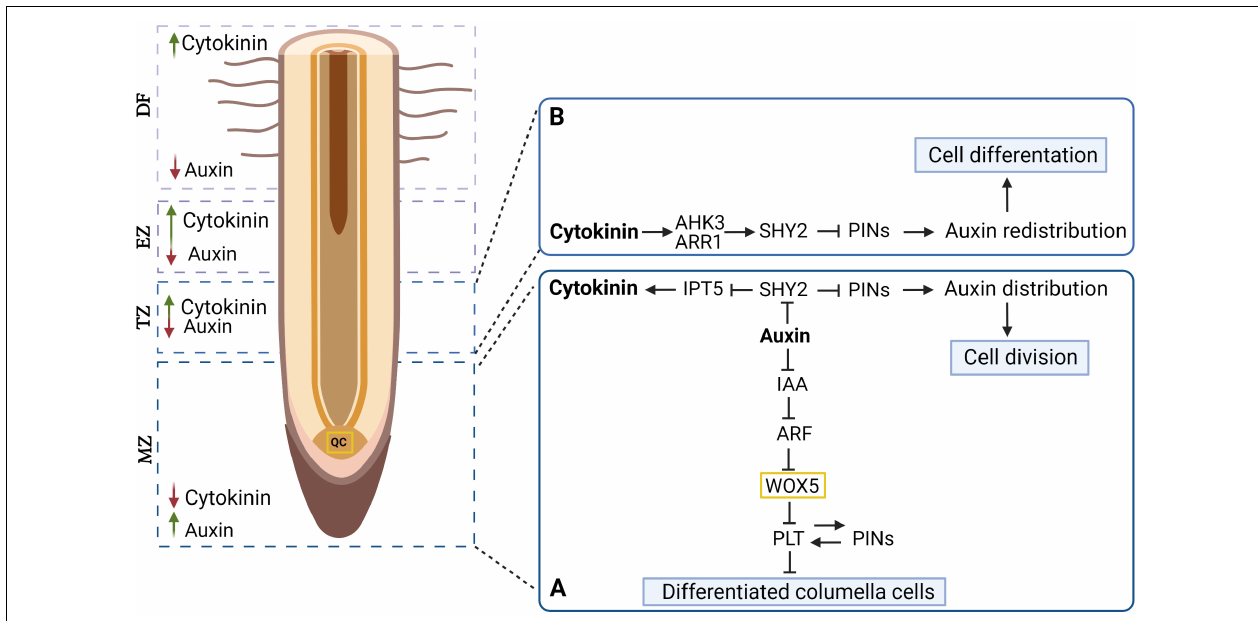
FIGURE 2 | Mechanism of auxin and cytokinin interaction in root meristem development. The distribution of auxin and cytokinin in different lots of the longitudinal section of the tree root is shown (green arrow – higher level, red arrow – lower level). (A) Auxin mediating WOX5 (expressed in the quiescent center cells (QC) and PLT (expressed in the stem cells surrounding the QC) expression plays a key role in the differentiation of columella cells. Also, in the apical root meristem, auxin by degrading SHY2 proteins promotes the expression of PINs, which control the auxin gradient and subsequently affect cell division. (B) In contrast to the auxin, cytokinin inhibits PIN expression by promoting SHY2 expression, leading to auxin redistribution and cell differentiation. PLT, PLETHORA; PINs, PINFORMED; WOX, WUSCHEL RELATED HOMEOBOX 5; ARF, AUXIN RESPONSE FACTOR; IAA, INDOLE-3-ACETIC ACID; SHY2, SHORT HYPOCOTYL 2; IPT5, ISOPENTENYL-TRANSFERASE 5; AHK3, ARABIDOPSIS HIS KINASE 3; ARR1, ARR TRANSCRIPTION FACTORS; MZ, meristematic zone; TZ, transition zone; EZ, elongation zone; DF, differentiation zone, QC, quiescent centre [based on Su et al. (2011)]. Created with